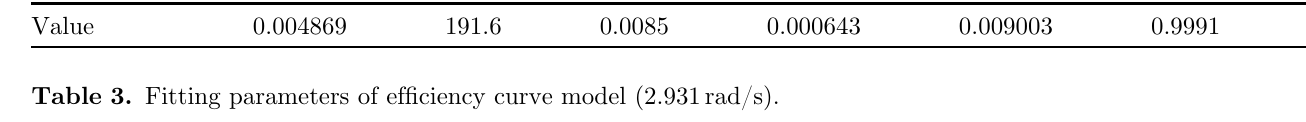
Table 2. Fitting parameters of ef fi ciency curve model (1.884 rad/s). Parameters